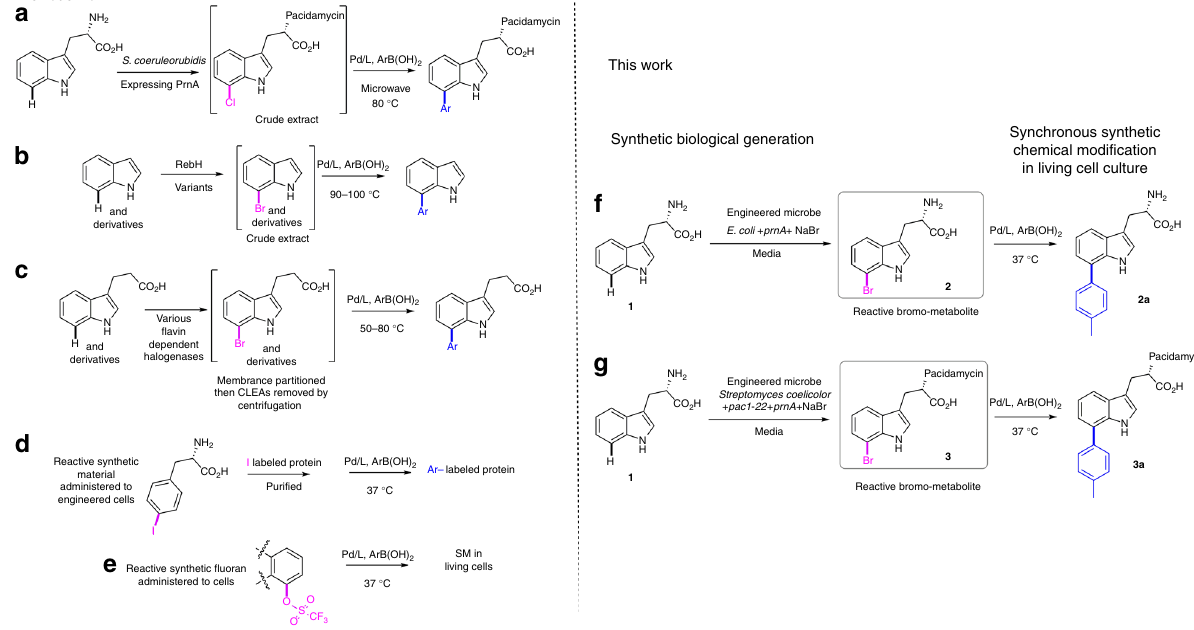
Fig. 1 Biosynthetic halogenation enabling Suzuki – Miyaura cross-coupling. a in vivo generation of Cl-pacidamycin, by the natural producer, transformed with a halogenase, followed by in vitro cross-coupling of the compound as a component of cell free extract, at 80 °C (in vivo: in vitro) 8 , b in vitro generation of reactive bromo-aromatics by RebH variant enzymes, followed by in vitro cross-coupling of the compound as a component of the crude extract (in vitro: in vitro) 11 , c in vitro generation of reactive bromo-aromatics by stabilized crosslinked enzyme aggregates ((CLEAs) of a series of fl avin-dependent halogenases, membrane partitioned from anaerobic, palladium-mediated cross-coupling conditions (in vitro: in vitro) 12 , d in vivo incorporation of reactive, synthetic iodophenylalanine into peptides, followed by protein puri fi cation and cross-coupling of the iodinated protein (in vivo: in vitro) 13 , e in vivo Suzuki – Miyaura modi fi cation of synthetically generated, reactive tri fl ate fl uoran (synthetic: in vitro) 14 , f in vivo g eneration of reactive 7-Br-tryptophan 2 by engineered E. coli RG-1500 synchronous with the in-culture Suzuki – Miyaura cross-coupling of this reactive metabolite (in vivo: in vivo); and g generation of reactive Br-pacidamycin D 3 by engineered Streptomyces coelicolor RG-1104 concomitant with the in-culture Suzuki – Miyaura cross-coupling of this reactive metabolite (in vivo: in vivo) NATURE COMMUNICATIONS | 8: 229 | DOI: 10.1038/s41467-017-00194-3 |